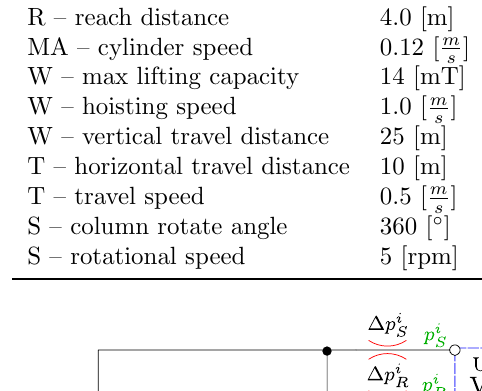
Table 2: Actuator requirements of the PRM.